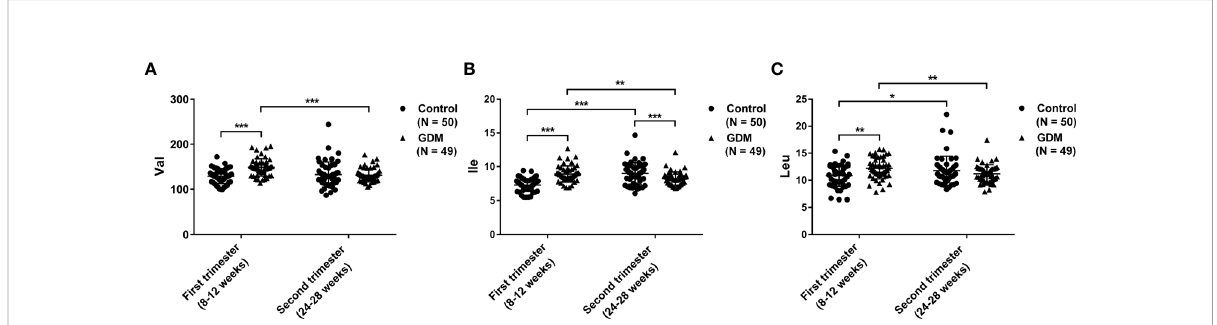
FIGURE 1 The dynamic changes of serum branched-chain amino acids (BCAAs) in patients with gestational diabetes mellitus (GDM) and normal controls in the fi rst and second trimesters. (A) Valine (Val); (B) Isoleucine (Ile); (C) Leucine (Leu). The differences on the mean levels of BCAAs between GDM (N = 49) and control (N = 50) groups for different trimesters are tested using independent Student ’ s t-test in the fi rst or second trimester, respectively. The differences on the mean levels of BCAAs between the fi rst and second trimesters for different groups are tested using paired Student ’ s t-test in the same cohort of GDM (N = 49) or control (N = 50) groups, respectively. *P < 0.05, **P < 0.01, ***P < 0.001.